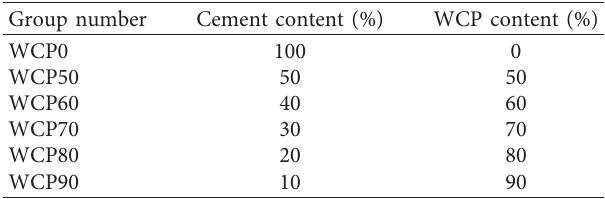
Figure 4: SEM images of WCP: (a) 100x, (b) 800x, and (c) 5000x. Table 2: Test ratios of phase